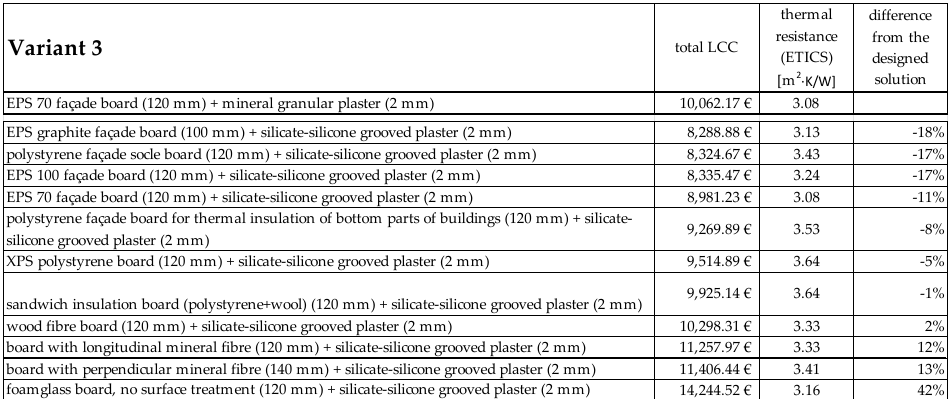
Figure 6. Output of the LCC calculation for Variant 2.